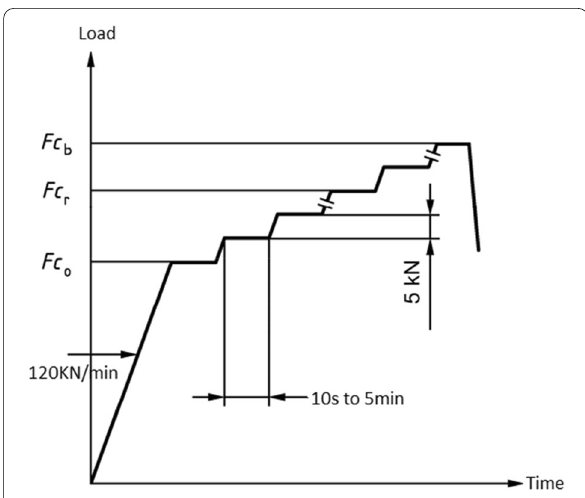
Fig. 6 Loading steps of the positive bending test (E. B. 13230-2, 2009).